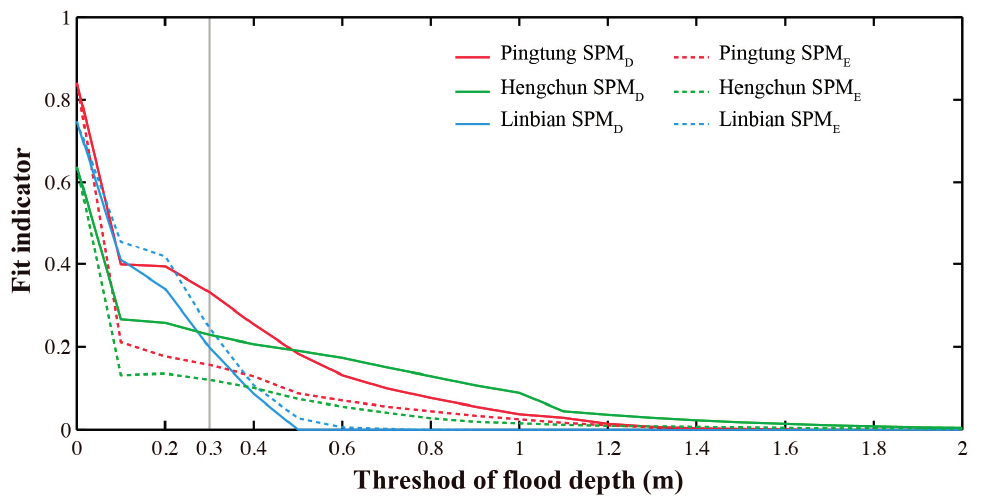
Figure 11. Comparison of the model performance between SPM D and SPM E using the performance indicator for various threshold